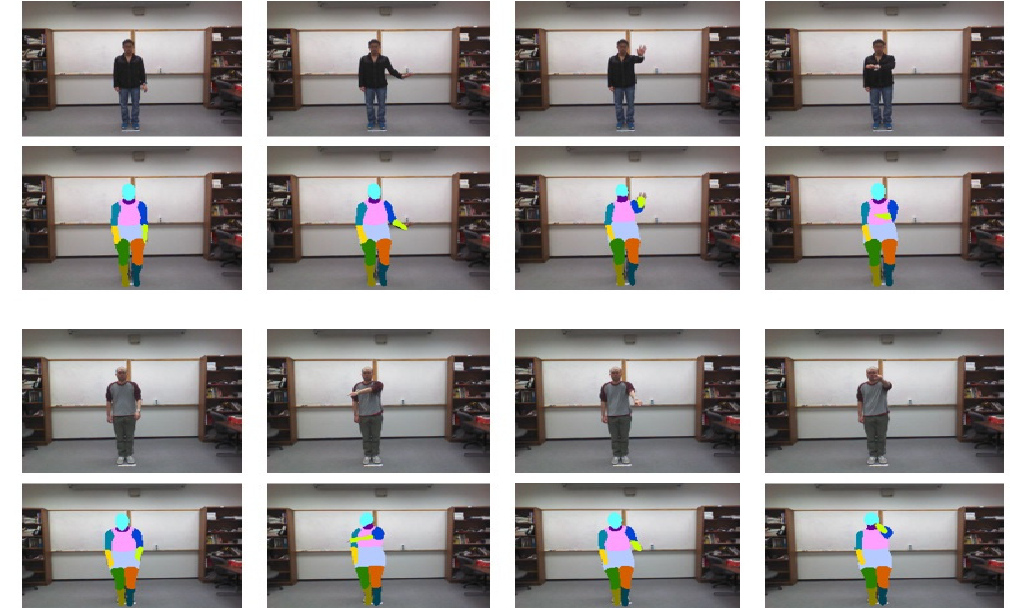
Figure 4. Example of color-encoded 12 body parts segmentation from RGB images sequence by the RefineNet model.